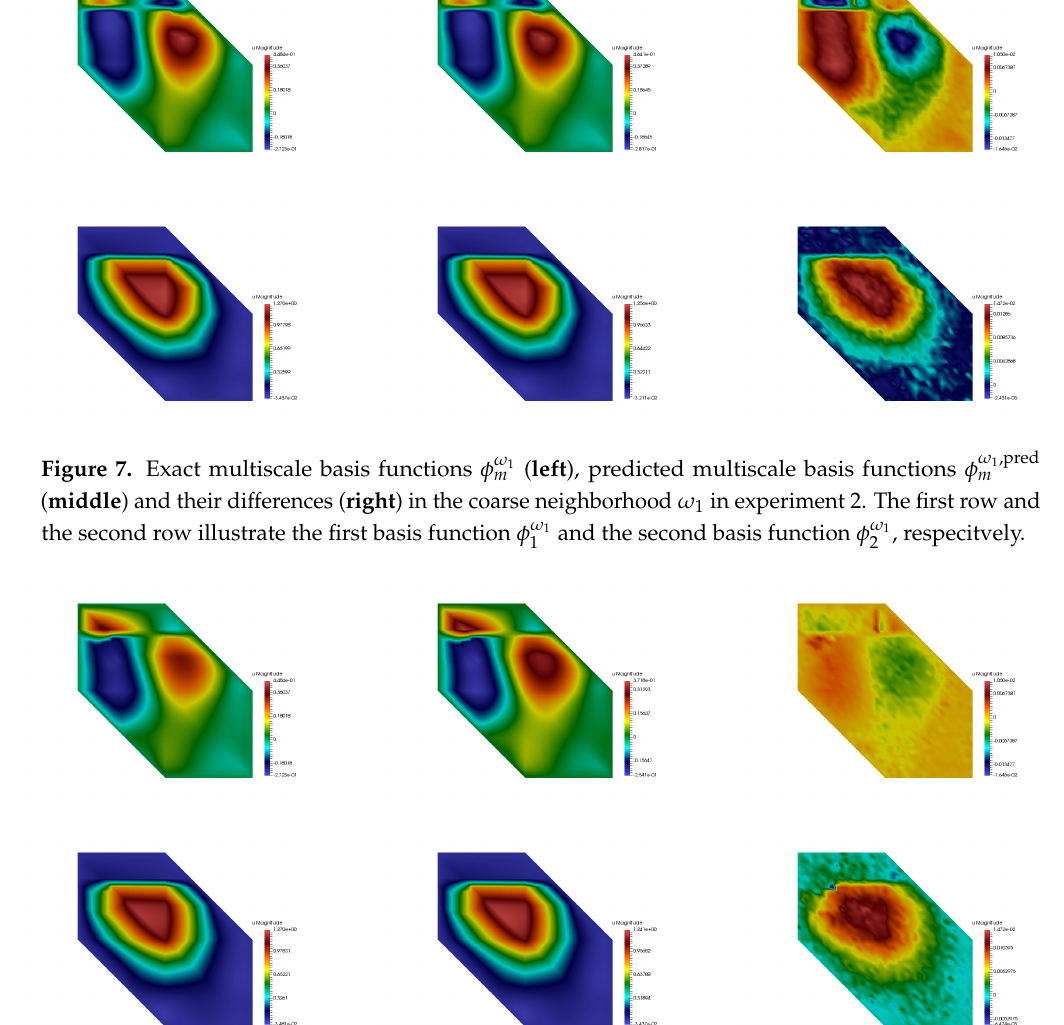
Figure 8. Exact multiscale basis functions φ ω 2 m ( left ), predicted multiscale basis functions φ ω 2 ,pred m ( middle ) and their differences ( right ) in the coarse neighborhood ω 2 in experiment 2. The first row and the second row illustrate the first basis function φ ω 2